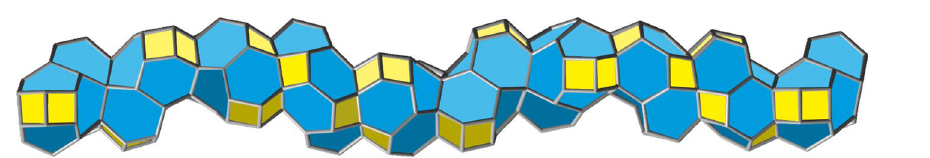
Figure 16. Perspective of a helix made by fusion of nugget 28b via its hexagonal face, of formula C 226 H 172